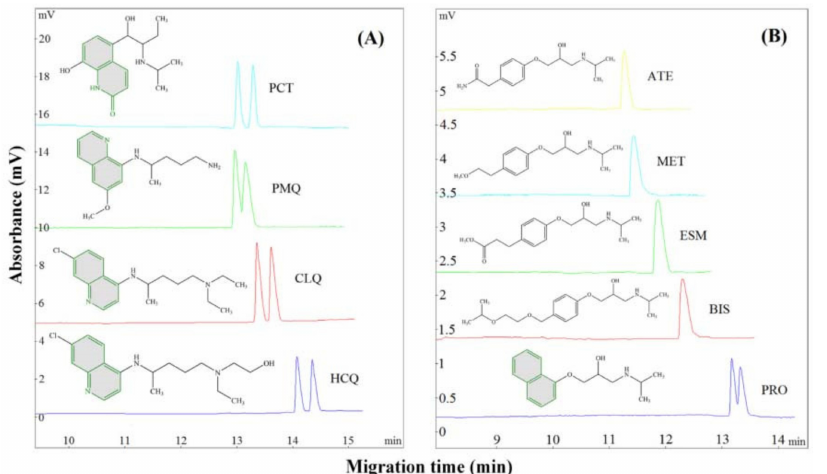
Figure 11. Enantioseparation of model drugs using fusidic acid as CS (PCT—procaterol, PMQ— primaquine, CLQ—chloroquine, HCQ—hydroxychloroquine, ATE—atenolol, MET—metoprolol, ESM—esmolol, BIS—bisoprolol, PRO—propranolol), (CS concentration 60 mM), (the rigid planar structure (if any) of model drugs is drawn in grey). ( A ) Enantioseparation of PCT, PMQ, ClQ and HCQ; ( B ) Enantioseparation of ATE, MET, ESM, BIS, PRO. The figure is reproduced from Zhang et al. [77] with permission from